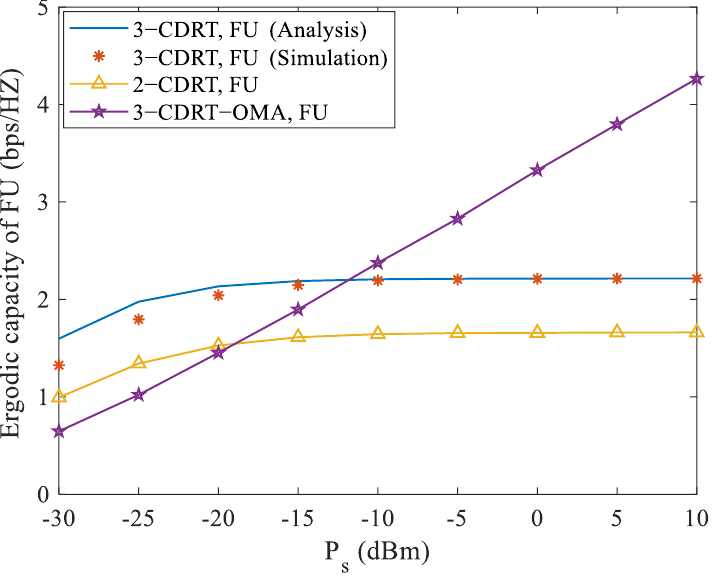
Figure 4. Comparison among the proposed 3 − CDRT strategy, the 2 − CDRT strategy and the 3 − CDRT − OMA strategy in terms of the ergodic capacity of FU with varying P s (dBm). Meanwhile, we can see that with the increase of P s , C F under the 2 − CDRT